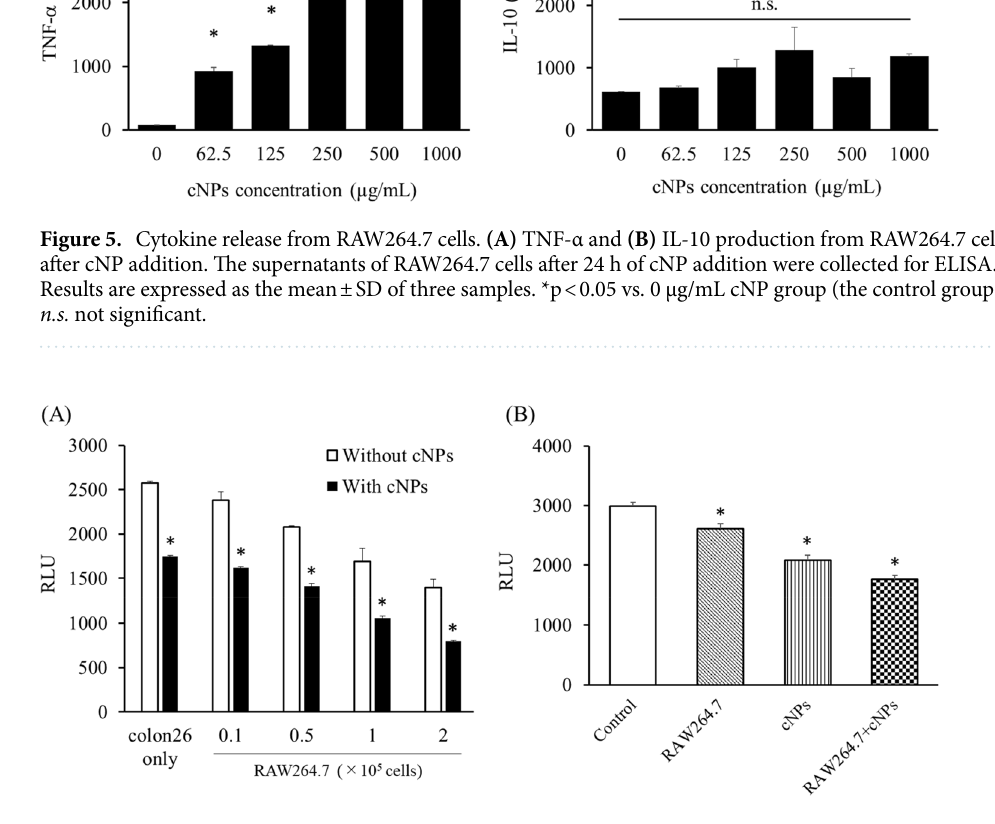
Figure 6. Combined effect of cNPs and RAW264.7 cells on the proliferation of colon26/fluc cells. (A) Co-incubation of RAW264.7 cells with colon26/fluc cells with or without cNPs. After 24 h-incubation, cells were lysed, and luciferase activity was measured. Results are expressed as the mean ± SD of three samples. *p < 0.05 vs. without cNP (no treatment) group. (B) Colon26/fluc cells were seeded onto the bottom of Transwell, and RAW264.7 cells with or without cNPs were added to the insert well (upper bottom). After 24 h-incubation, colon26/fluc cells were lysed and luciferase activity was measured. Results are expressed as the mean ± SD of three samples. *p < 0.05 vs. control